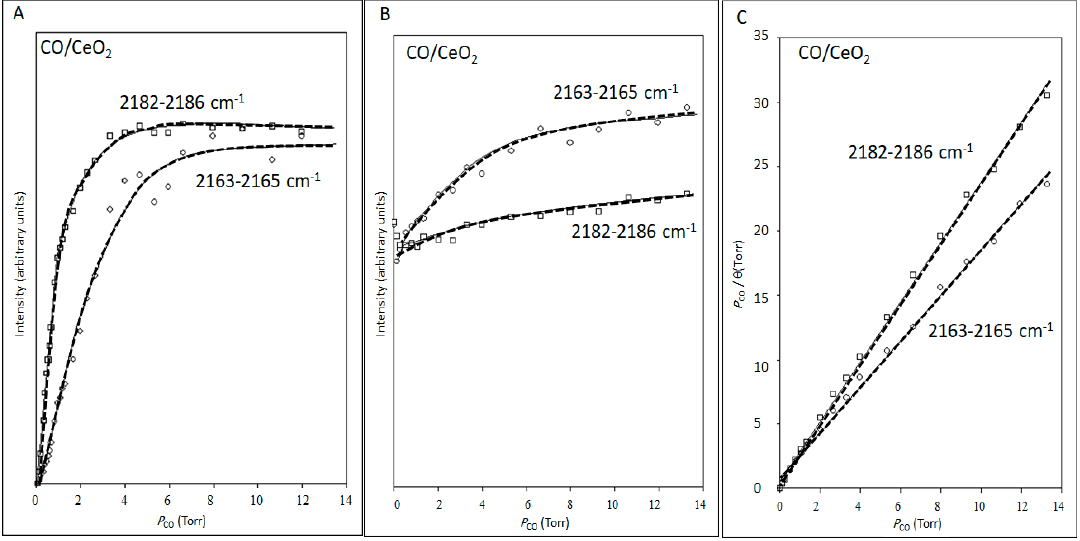
) 2165 (cid:35) ) 2163 cm − 1 ) (cid:35)